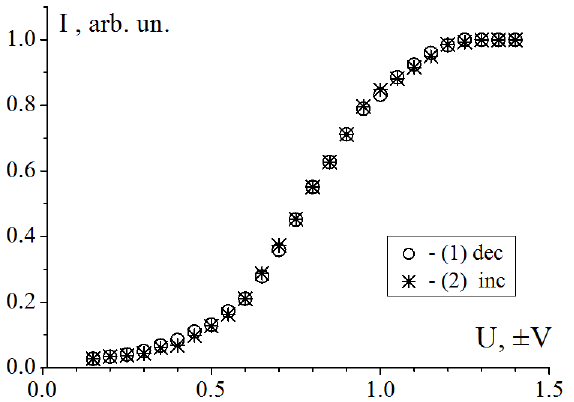
Figure 11. Dependence of the light transmission on the electrical voltage for the frequency 6 kHz at decreasing (1) and increasing (2) voltage. The thickness of the electro-optical cell with the HF-32C composition is 1.7 μm.